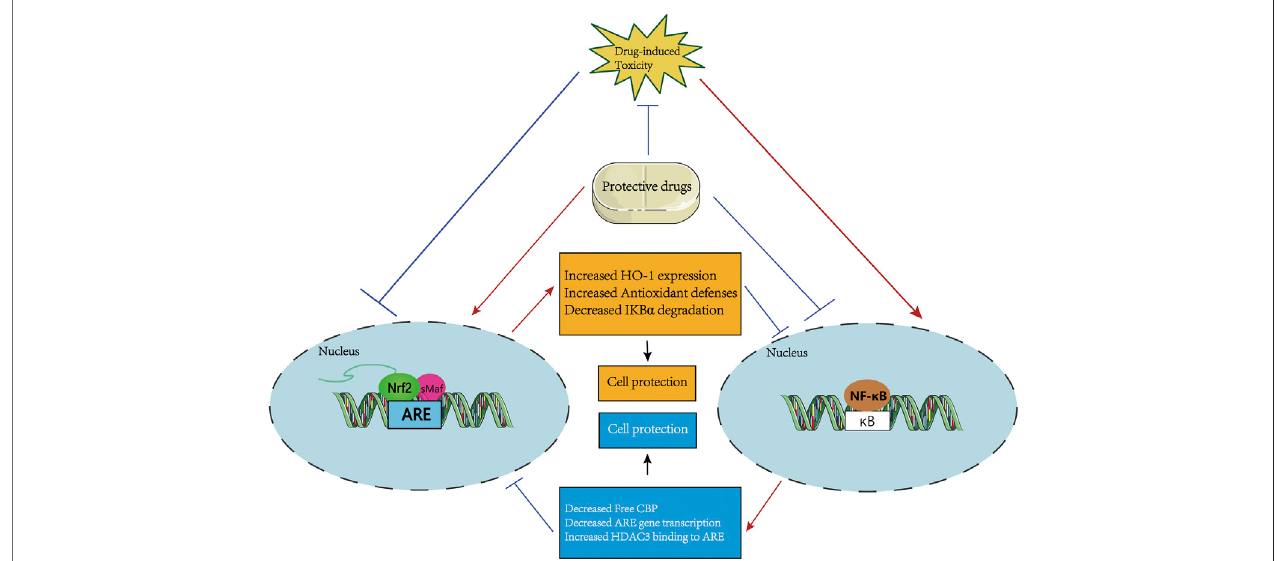
FIGURE 4| A systematic schematic of protective agentsagainst drug-induced toxicity via modulating the mutual interference between Nrf2 and NF- κ B pathways. The protective candidates improve the antioxidant capacity by activating the Nrf2 pathway and inhibiting the NF- κ B-mediated in fl ammatory response, thereby antagonizing the drug-induced organ toxicity. Speci fi cally, on the one hand, the protective agents directly or indirectly activate the Nrf2 signaling, then prevent I κ B α degradation, or increase HO-1 expression to inhibit NF- κ B activation, thereby increasing antioxidant defense ability to resist drug-induced toxicity. On the other hand, the protective agents may inhibit the nuclear translocation of NF- κ B which activating by drug-induced toxicity to increase the activation of the Nrf2 pathway by increasing ARE gene transcription and Free CBP, and reducing the recruitment of HDAC3 to the ARE region.